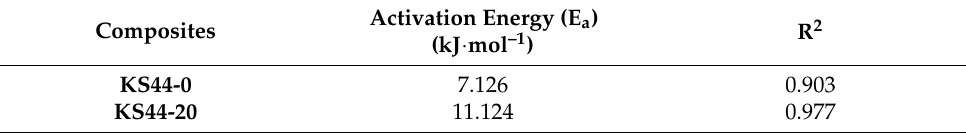
Table 6. Determined activation energies of the adsorption of RhB onto KS44-0 and